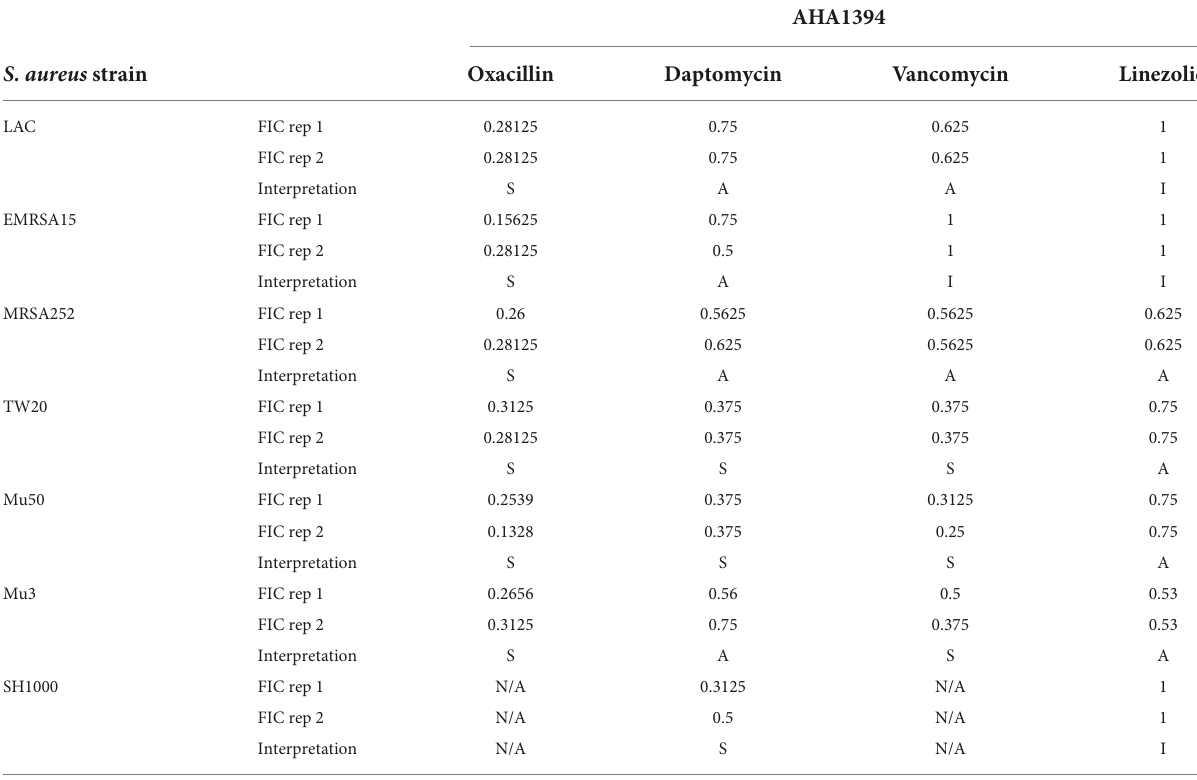
TABLE 3 The synergy of AHA-1394 with clinically relevant antibiotics is strain dependent.